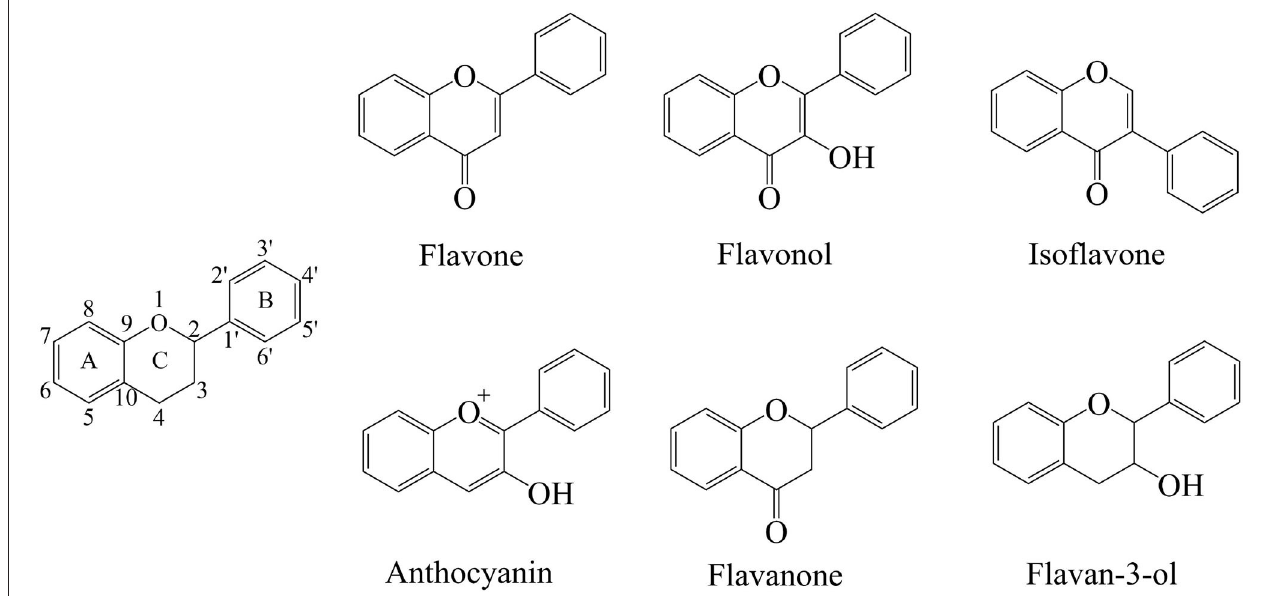
FIGURE 2 | Skeleton structure diagram of